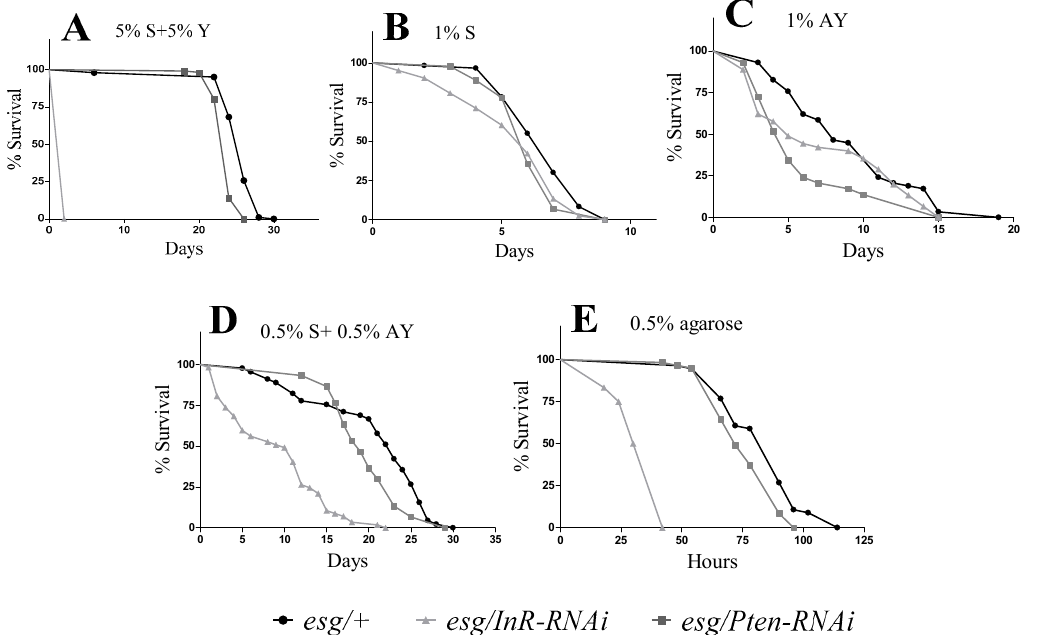
Figure 1. Survival curves for the experimental flies with insulin–IGF-1 signaling (IIS) manipulated in stem and progenitor cells under various dietary conditions: A —standard medium (5%S + 5%Y); B —low carbohydrate diet (1%S); C —low protein diet (1%AY); D —balanced malnutrition diet (0.5%S + 0.5%AY); E —complete starvation (0.5% agarose). The readout of the experimental days starts initially